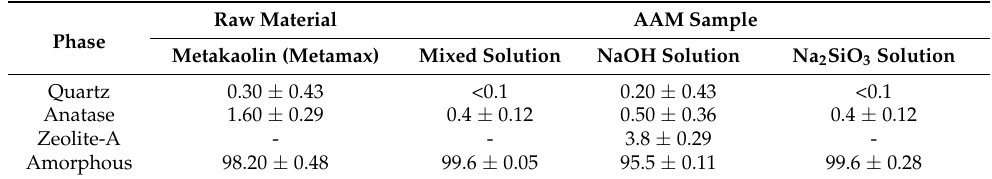
Table 3. Results of the Rietveld analysis of metakaolin and AAM samples produced using different alkali activators.